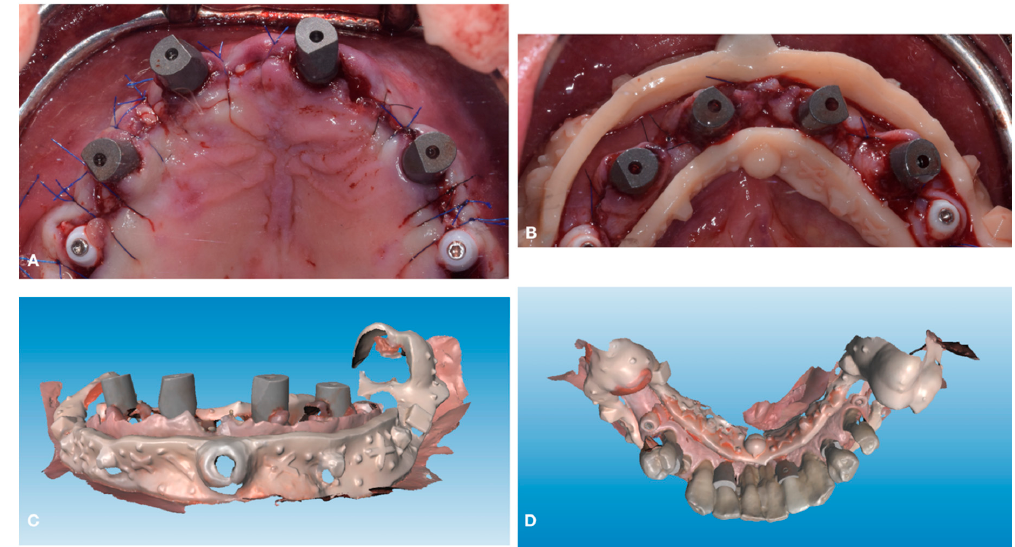
Figure 7. Scan abutments and the lower digital index placement. ( A ) Scan abutment placement after implants insertion. ( B ) Placement of the digital index immediately after surgery to record the postoperative digital impression. ( C ) Postoperative digital impression in frontal view. ( D ) Occlusal view of the mandibular postoperative digital impression superimposed with the preoperative scan using the resin digital index as reference.